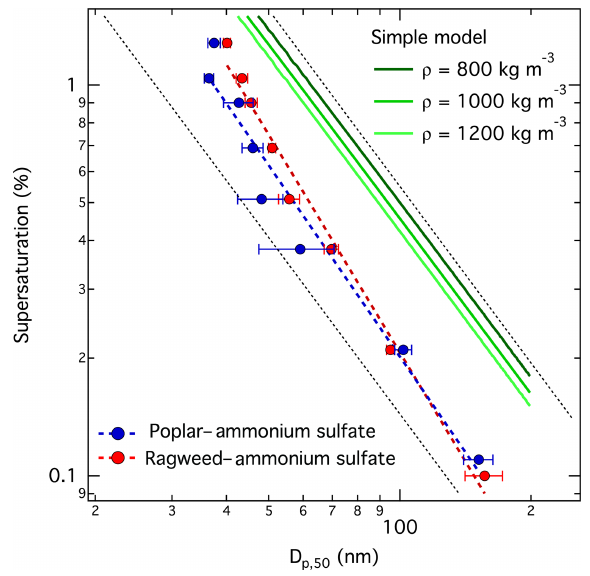
Figure 6. CCN activity modeled with the simple partitioning model for particles comprising pollenkitt and 20% by mass of ammonium sulfate. The simple model predicts the same CCN activation for all organics, given a specified dry organic mass density, as explained in the text. Model results are shown here for assumed pollenkitt densities of 0.8, 1.0, and 1.2gcm − 3 together with measured CCN activation for poplar and ragweed mixtures with ammonium sulfate. Dashed black lines have slope − 3 / 2 in double logarithmic space and are shown on the graph to guide the